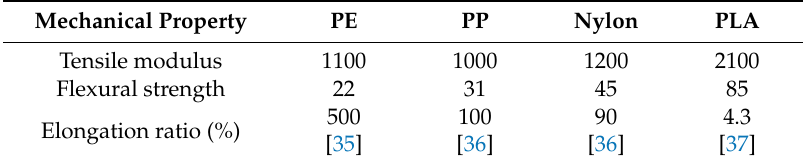
Table 3. Mechanical properties of four polymers used in the study: polyethylene (PE), polypropylene (PP), nylon 12 (nylon), polylactic acid (PLA) (unit: MPa). Mechanical Property PE PP Nylon PLA Tensile modulus 1100 1000 1200 2100 Flexural strength Elongation ratio (%)